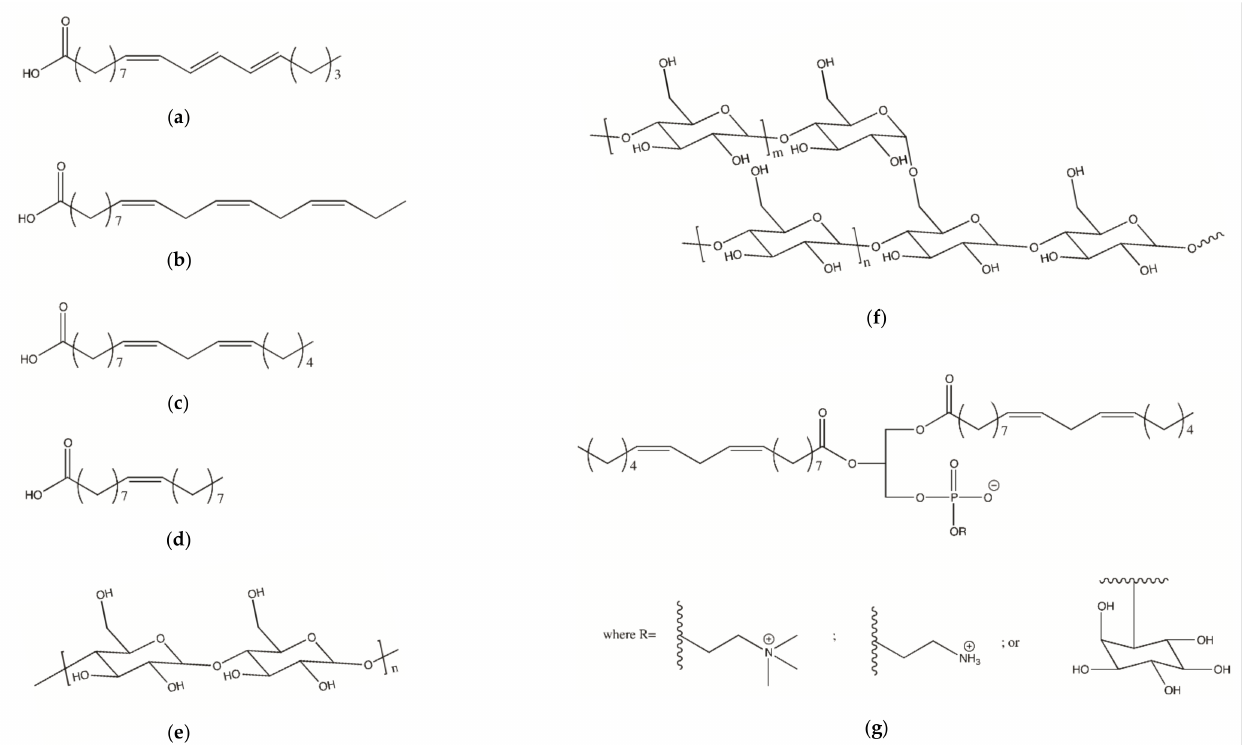
Figure 1. Chemical structures of ( a ) α -eleostearic acid, ( b ) linolenic acid, ( c ) linoleic acid, ( d ) oleic acid, ( e ) amylose, ( f ) amylopectin, and ( g ) a generic chemical representation of asolectin from